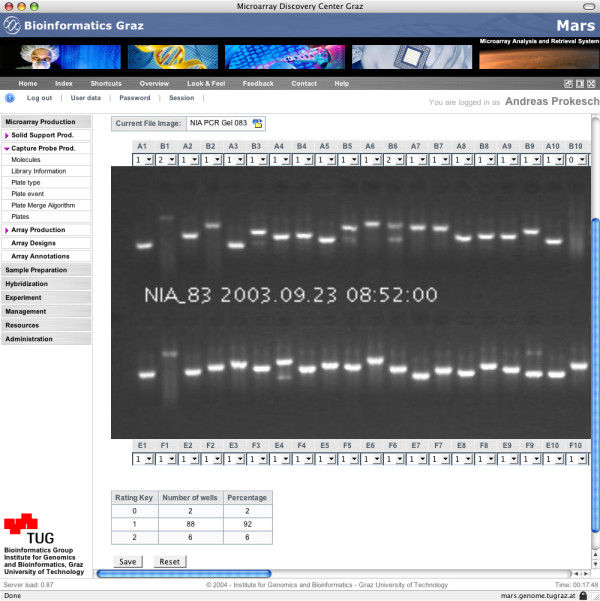
Quality control. A gel image from PCR products can be scored and associated to a plate.